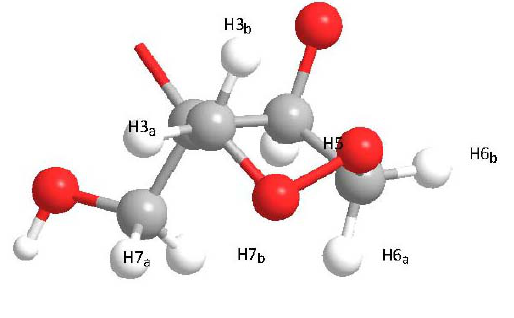
Figure 3. 3D structure of kramecyne